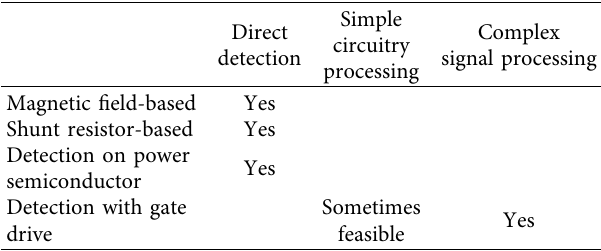
Table 3: Signal processing requirements for the over-current detection